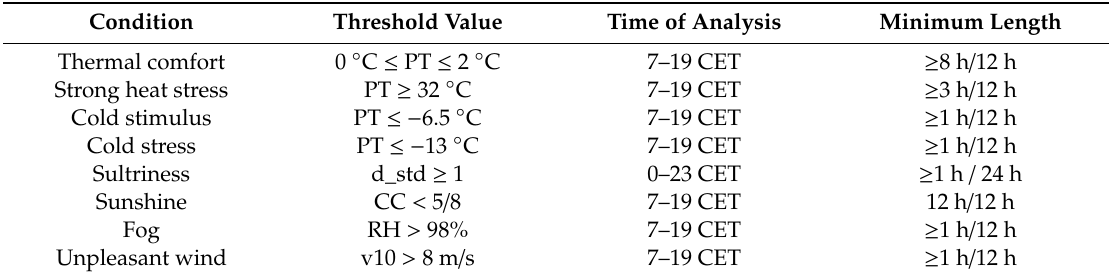
Table 3. Method applied to derive the